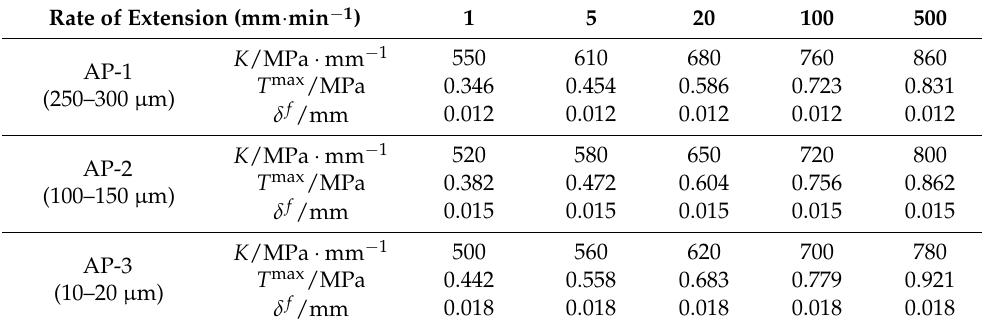
Table 3. AP interface mechanical model parameters obtained based on stepwise inversion